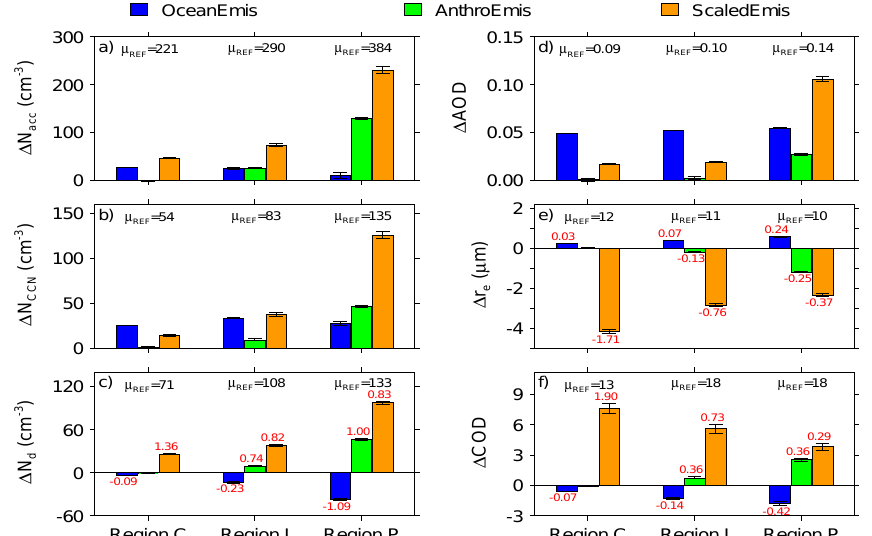
Fig. 2. Responses of aerosol and cloud properties to regional oceanic (OceanEmis, blue), anthropogenic (AnthroEmis, green), and enhanced anthropogenic (ScaledEmis, orange) emissions. The response, “ 1 ”, denotes differences in simulated quantities between two simulations with and without the specific regional emissions: REF-0OCE, REF-0ANT, and 5ANT-REF are used for assessing the response due to OceanEmis, AnthroEmis, and ScaledEmis, respectively. Panels (a–f) are for mean changes in accumulation mode aerosol ( N a , panel (a) at 975hPa), CCN ( N CCN at 0.1% supersaturation at 975hP, panel b ), cloud-top cloud droplet number ( N d , panel c ), aerosol optical depth (AOD, panel d ), cloud top effective radius ( r e , panel e ), and cloud optical depth (COD, panel f ), respectively. The mean aerosol or cloud properties in the reference simulation are shown at the top of each panel for each region (regions P, I, and C) as µ REF . The aerosol-cloud sensitivity factors, 1 ln (Y) , are shown in red above or below each color bar, where Y is the cloud property (e.g., N d , r e , and COD). More details regarding 1 ln (N ccn ) the aerosol-cloud sensitivity factor are provided in the main text. The error bars show the 95% confidence intervals of the mean changes estimated based on the temporal variation of hourly spatially averaged responses in each